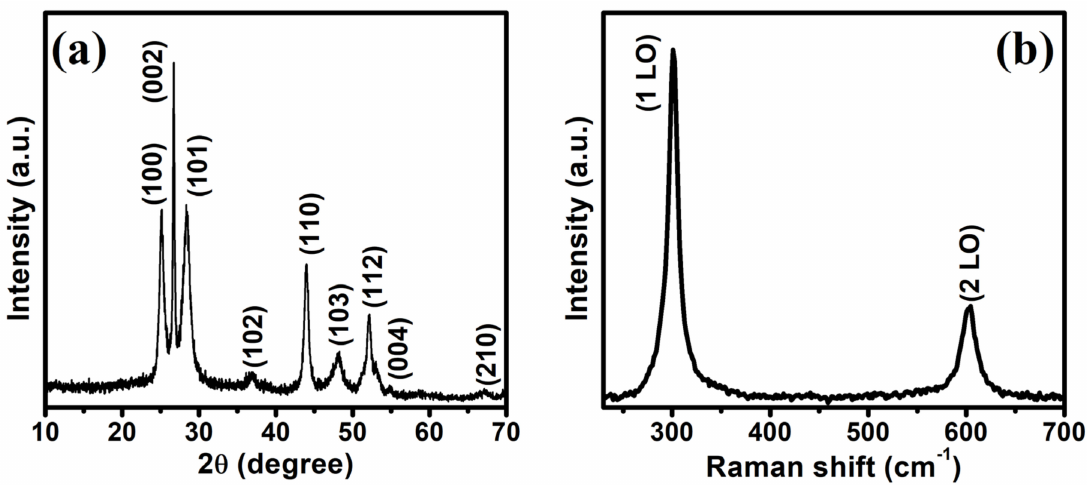
Figure 1. XRD patterns of CdS ( a ), Raman spectrum ( b ).